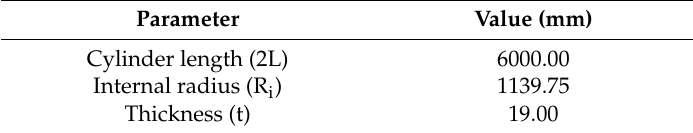
Table 2. Geometric parameters for hollow cylinder. Data taken from Ramos